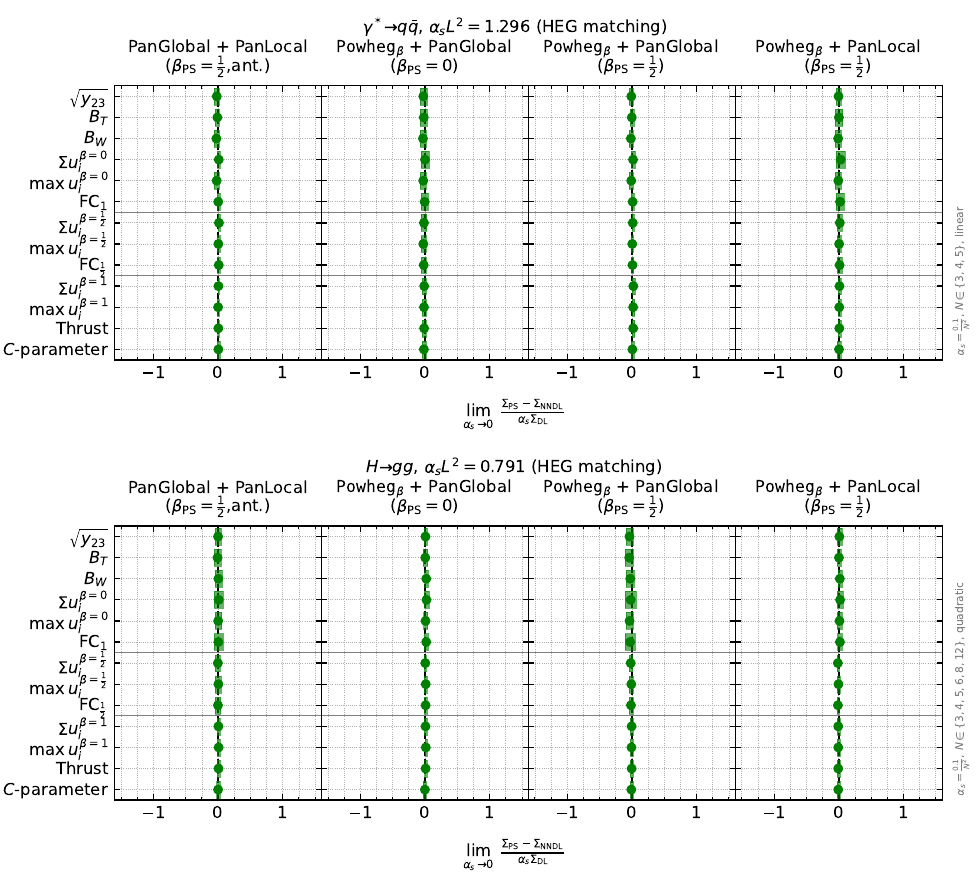
Figure 6. Results of NNDL accuracy tests for the four HEG/shower combinations shown in table 1.